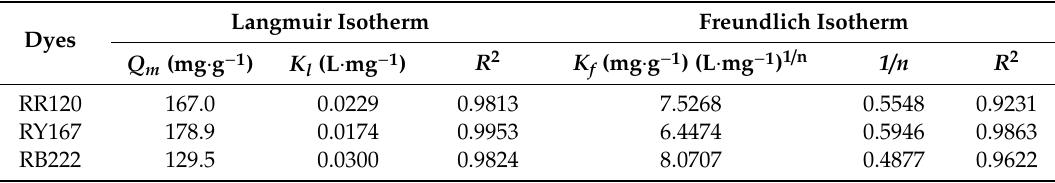
Figure 6. ( a ) E ff ect of pH on the adsorption of RR120, RY167, and RB222 onto the CL powders (m = 0.3 g, V = 50 mL, C 0 = 50 mg · L − 1 , T = 30 ◦ C, T = 100 min); ( b ) mean zeta potential of RR120, RY167, RB222, and CL powders, respectively; ( c ) photograph of the dye solution before and after the adsorption by the CL powders at the pH of 3.0 and initial concentration of 50 mg · L − 1 ; ( d ) Langmuir and ( e ) Freundlich adsorption isotherms for the adsorption of RR120, RY167, and RB222 by the CL powders (m = 0.3 g, V = 50 mL, pH = 3.0, T = 30 ◦ C); ( f ) photograph of the CL powders after the adsorption of RR120, RY167, and RB22, respectively. Table 1. Langmuir and Freundlich isotherm parameters for the adsorption of RR120, RY167, and RB222 onto the CL powders.